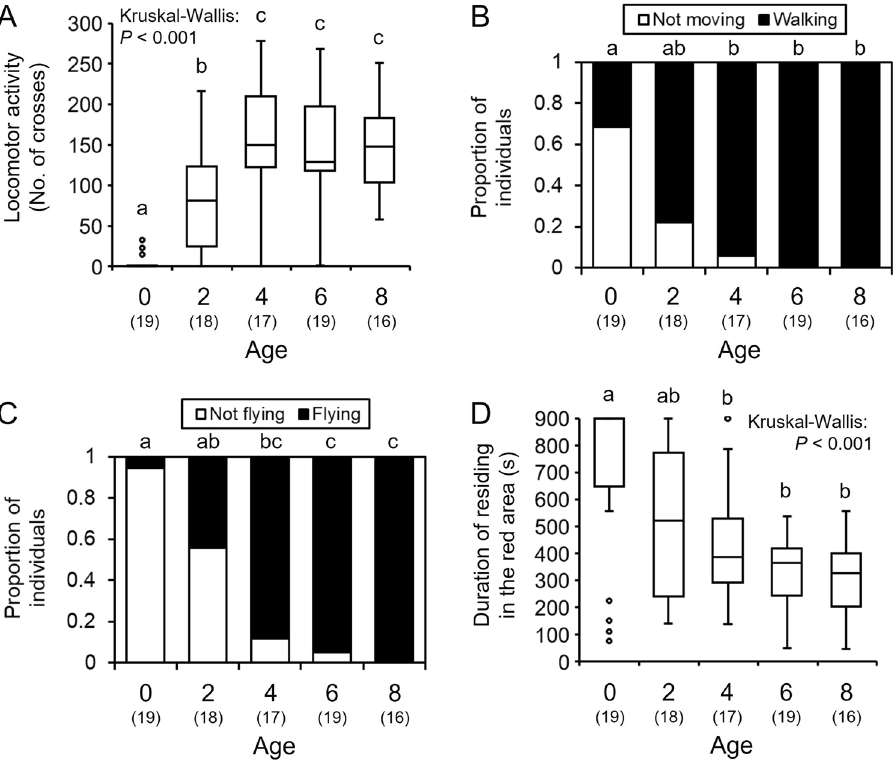
Figure 3. Age-dependent changes in behavioral activities in bumble bee males: ( A – B ) spontaneous locomotor activity, ( C ) spontaneous flight activity, and ( D ) light preference indicated by duration of residing in the red area. Locomotor activity and duration of residing in the red area are indicated by box plots. Significant differences according to the Steel–Dwass test ( P < 0.05) or Fisher’s exact test with Bonferroni correlation (P < 0.05) are indicated by different letters. Sample sizes are shown in